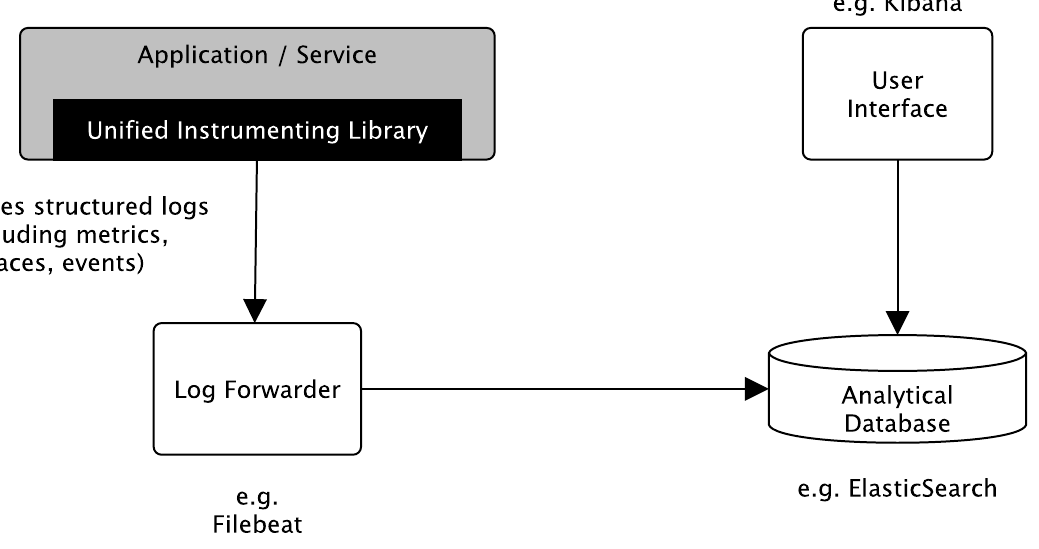
Figure 4. An observability system consistently based on structured logging with significantly re- duced